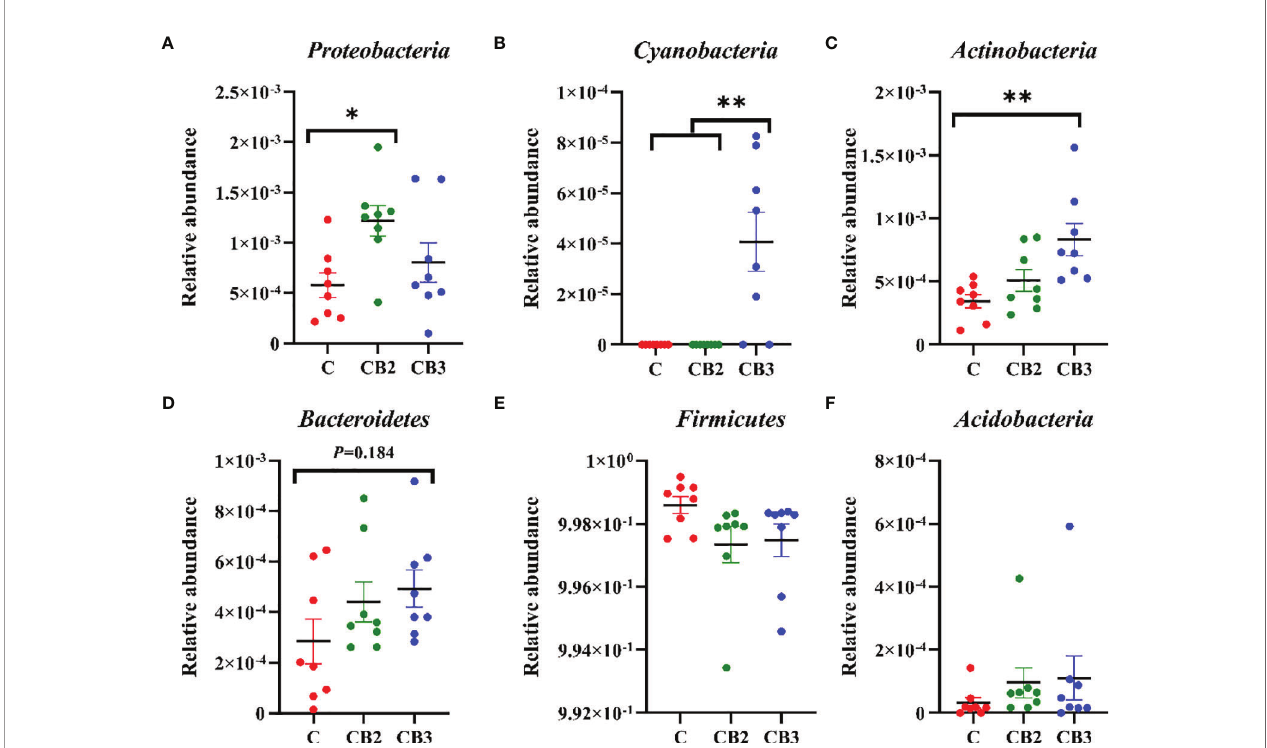
FIGURE 9 | Effects of dietary chitosan oligosaccharides (COS) and Clostridium butyricum synbiotic supplementation on the relative abundance of ileal microbiota at the phylum level in early-weaned pigeon squabs. (A) Proteobacteria. (B) Cyanobacteria. (C) Actinobacteria. (D) Bacteroidetes. (E) Firmicutes. (F) Acidobacteria. Values are means with the SEM of eight squabs. * p < 0.05 and ** p < 0.01. C group, control group, squabs fed with arti fi cial crop milk; CO group, squabs fed with arti fi cial crop milk + 150 mg/kg COS; CB2 and CB3 group, squabs fed with arti fi cial crop milk + 150 mg/kg COS + 300 and 400 mg/kg C. butyricum ,